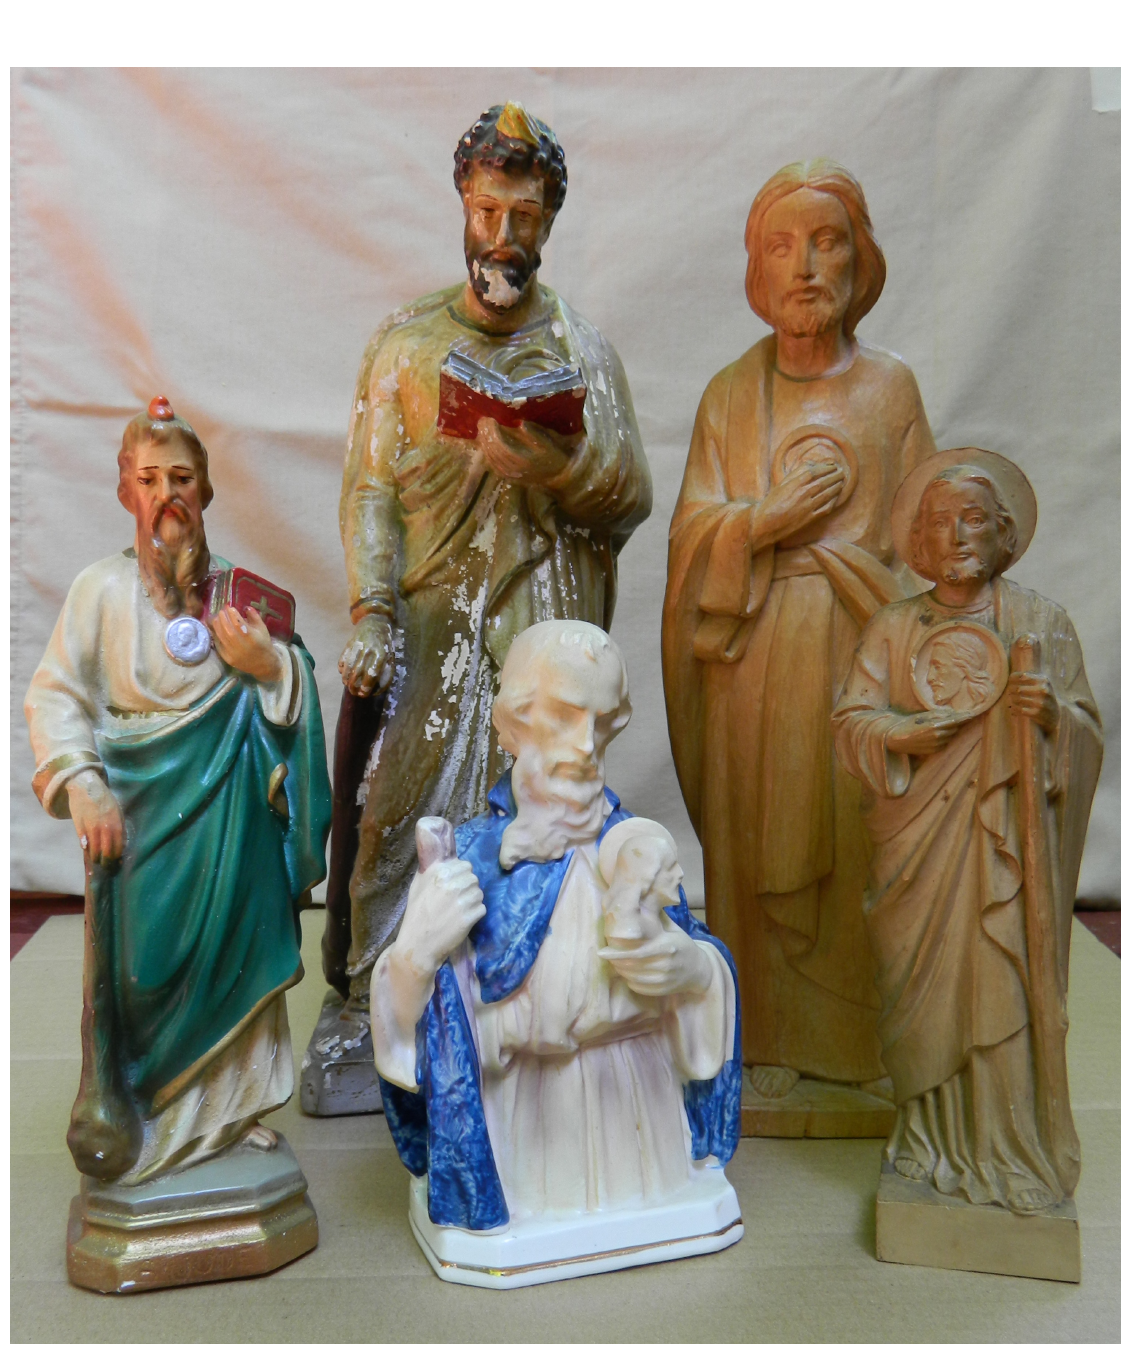
Figure 5 A variety of twentieth-century statuary of Saint Jude. Collection of the